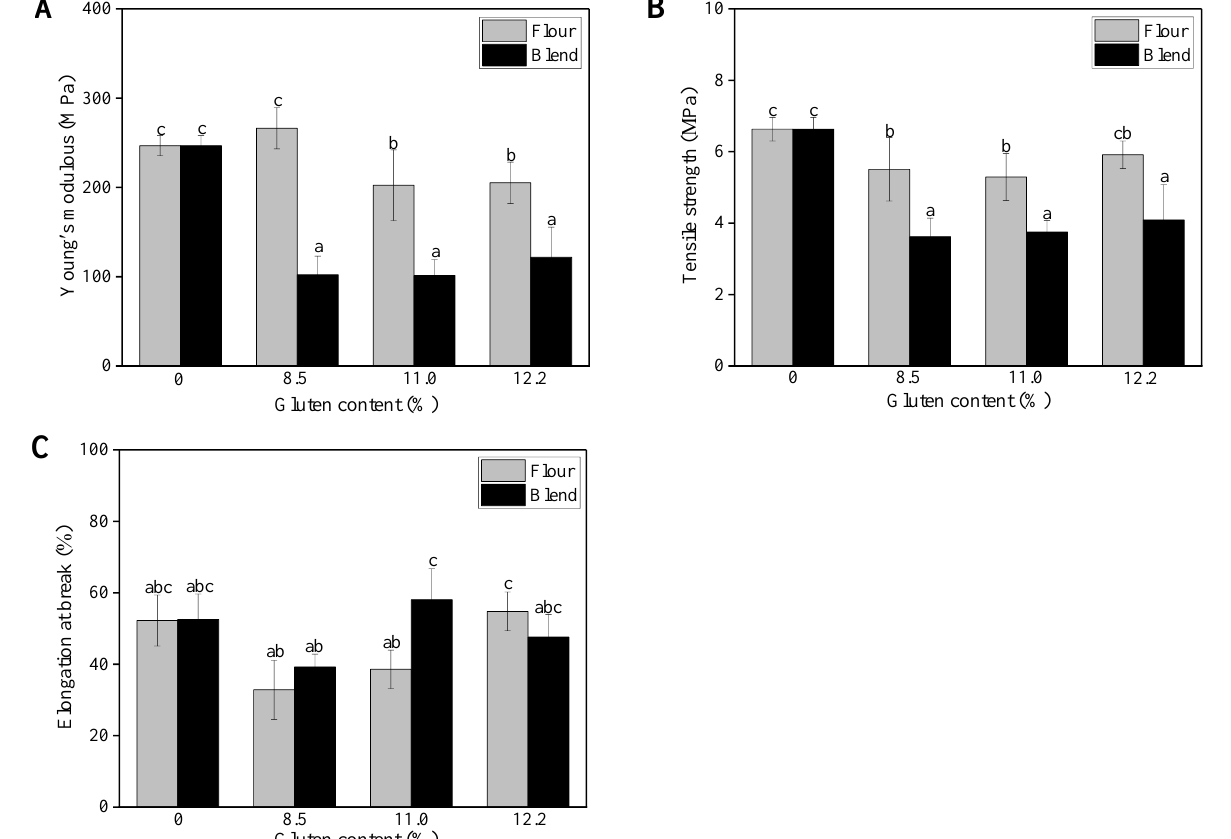
Figure 8. Tensile properties of the films of pure WS, wheat flours, and WS–gluten blends with different protein contents (8.5%, 11.0%, and 12.2%): ( A ) elastic modulus, ( B ) tensile strength, ( C ) elongation at break. Different letter (a, b, and c) means significant difference ( p <